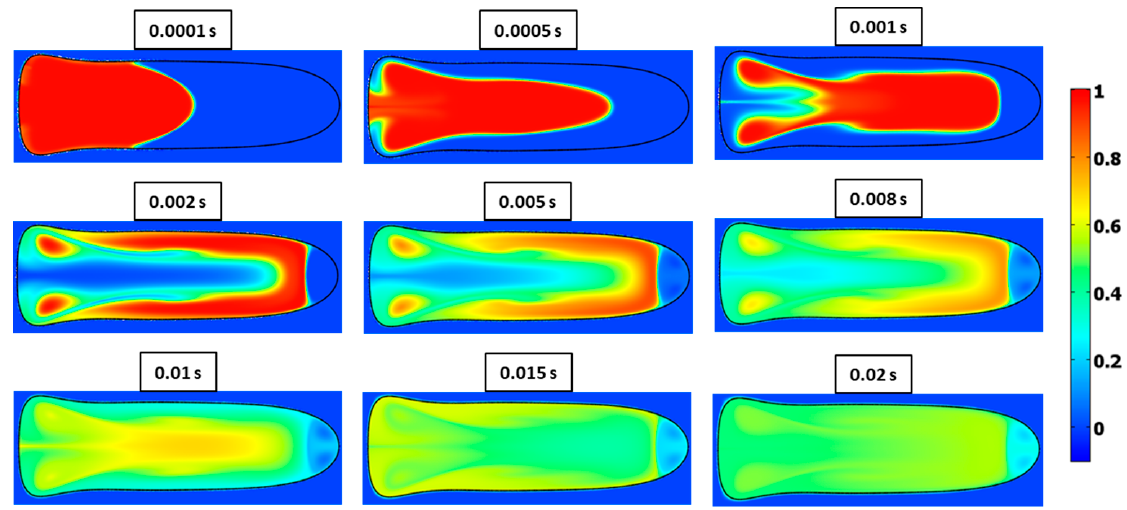
Figure 29. Surface plots of mixing at different times for 𝐶𝑎 = 0.21 and 𝜆 = 2 .